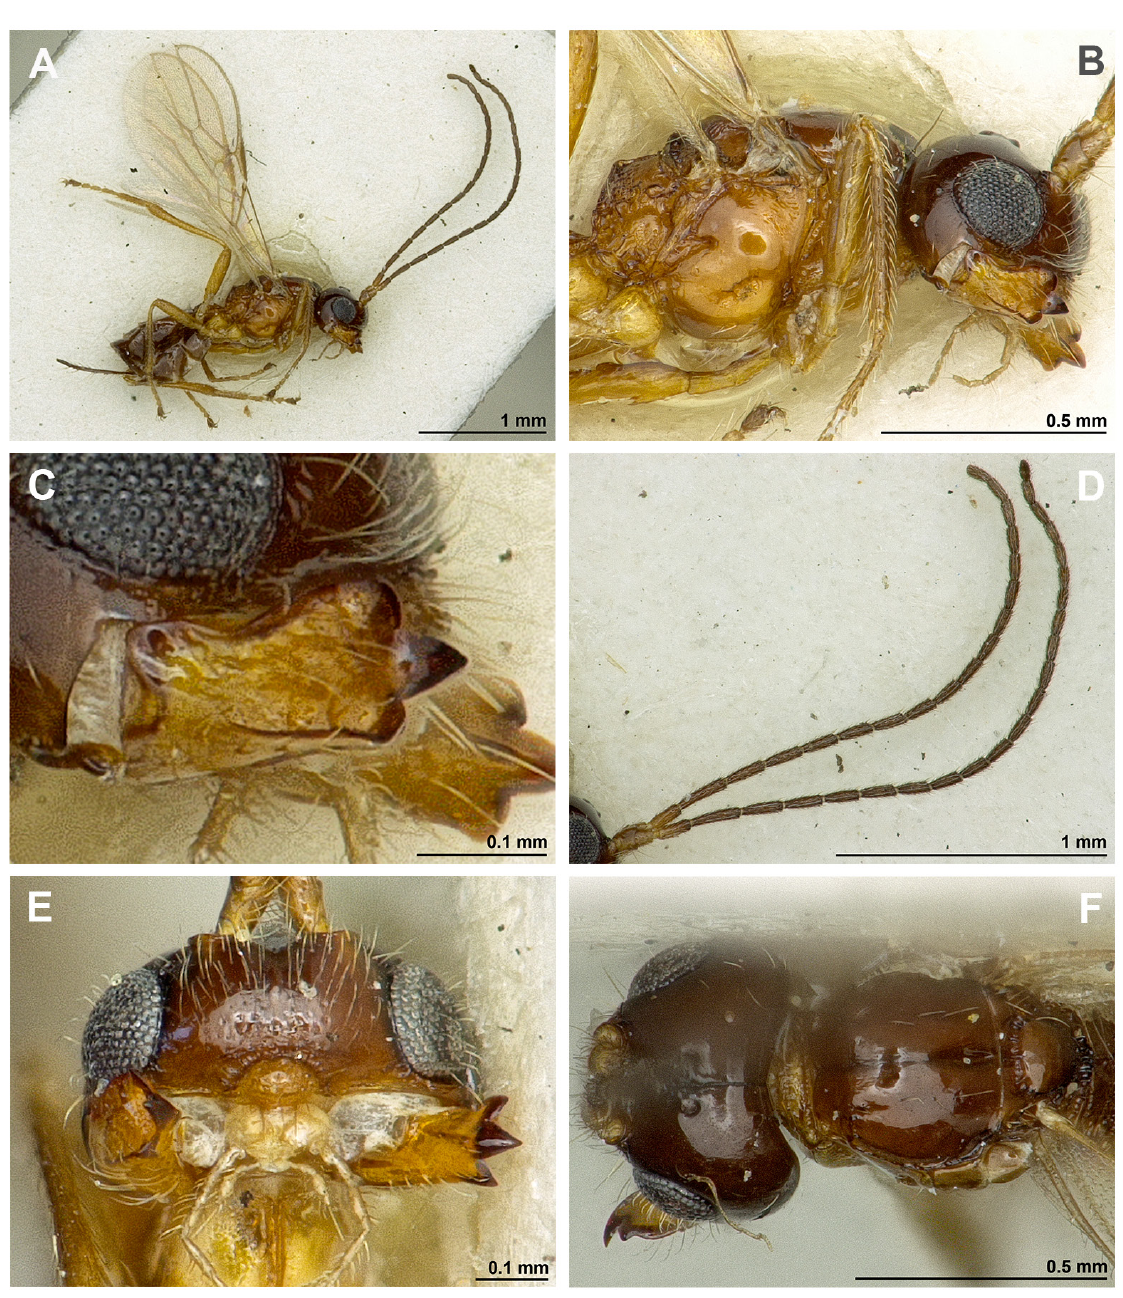
Fig. 7. Asobara carinata Peris-Felipo, sp. nov., ♀, holotype (BMNH 1922-97). A . Habitus, lateral view. B . Head and mesosoma, lateral view. C . Mandible. D . Antenna. E . Head, front view. F . Head and mesoscutum, dorsal